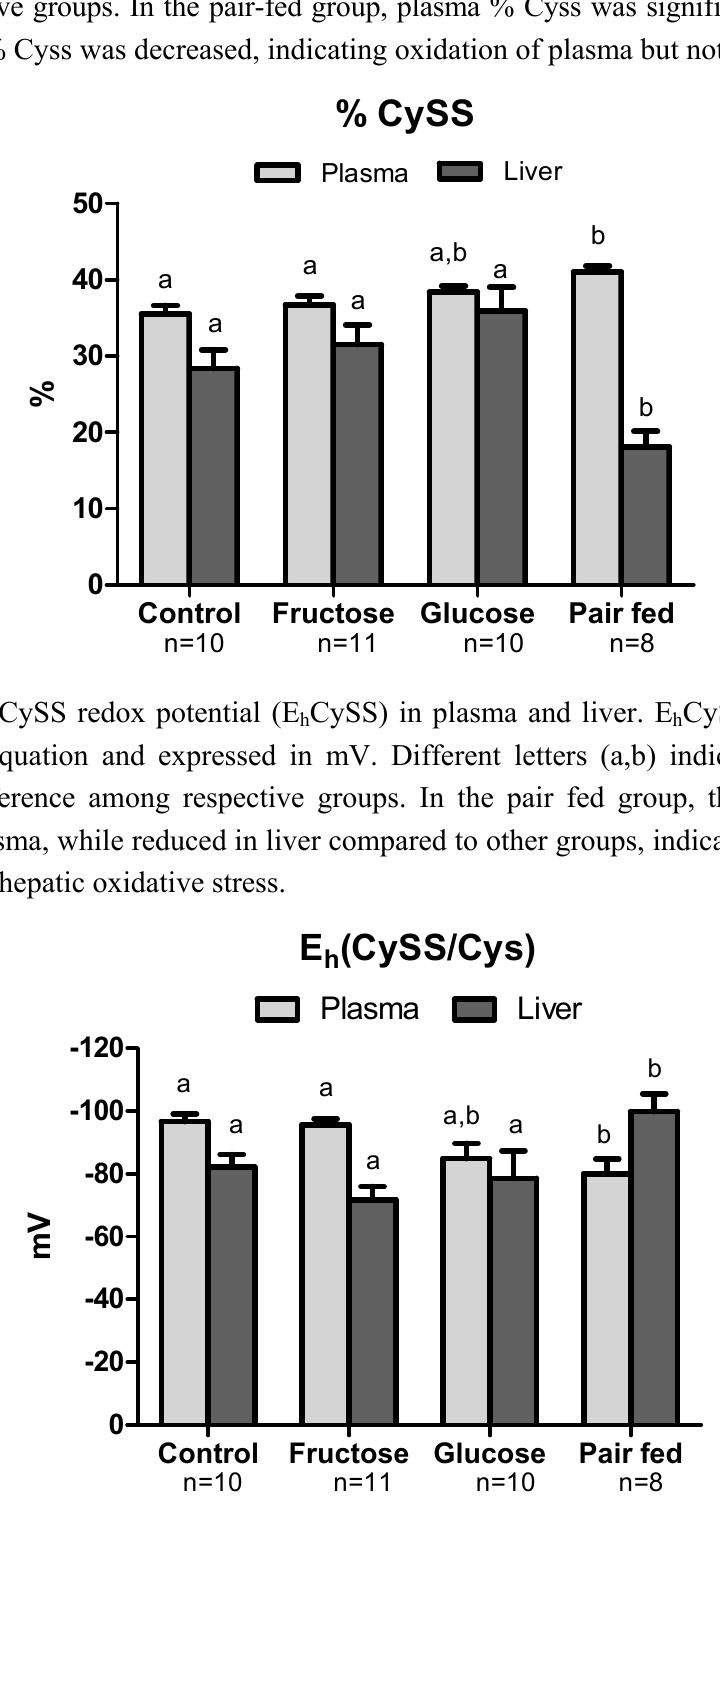
Figure 3. % CySS in plasma and liver. CySS was measured as percent of total Cys pool (Cys, CySS and Cys-GSH). Different letters (a,b) indicate statistically significant differences among respective groups. In the pair-fed group, plasma % Cyss was significantly increased while hepatic % Cyss was decreased, indicating oxidation of plasma but not liver.